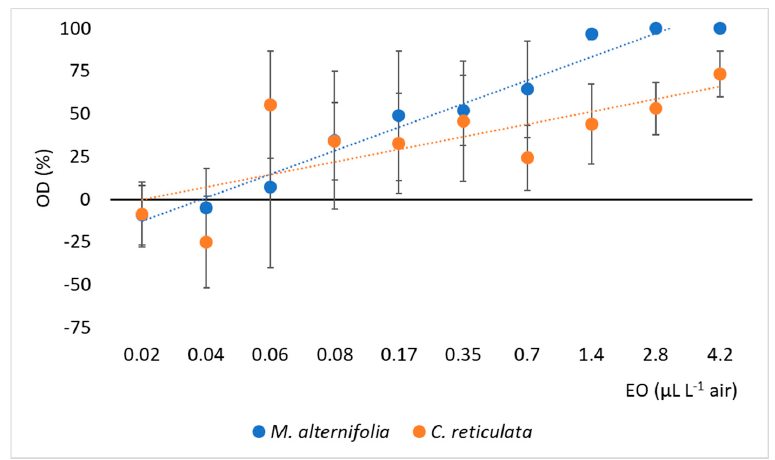
Figure 4. Deterrence of Melaleuca alternifolia and Citrus reticulata EOs on Drosophila suzukii oviposition. OD (%), percentage of oviposition deterrence. Regression equations M. alternifolia , y = 13.69x − 26.38; C. reticulata , y = 7.35x − 7.69. The bars represent the standard error. Overall, one-way ANCOVA showed no significant difference between the oviposition deterrence activity of C. reticulata and M. alternifolia EOs after controlling for the effects of the EO dose (F 1, 160 = 0.553; p = 0.458; η p2 = 0.003) with margin means (estimated at = 0.41 μ L L − 1 air) of 22.17 ± 7.78 and 31.23 ± 9.32 μ L L − 1 air, for C. reticulata and M. alternifolia EOs, respectively. However, M.